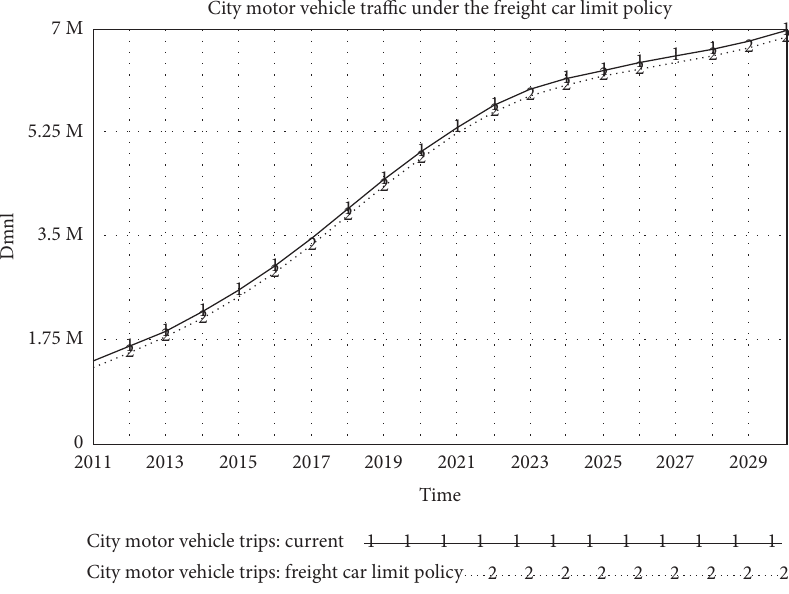
Figure 12: City motor vehicle trips under the restricted truck policy.